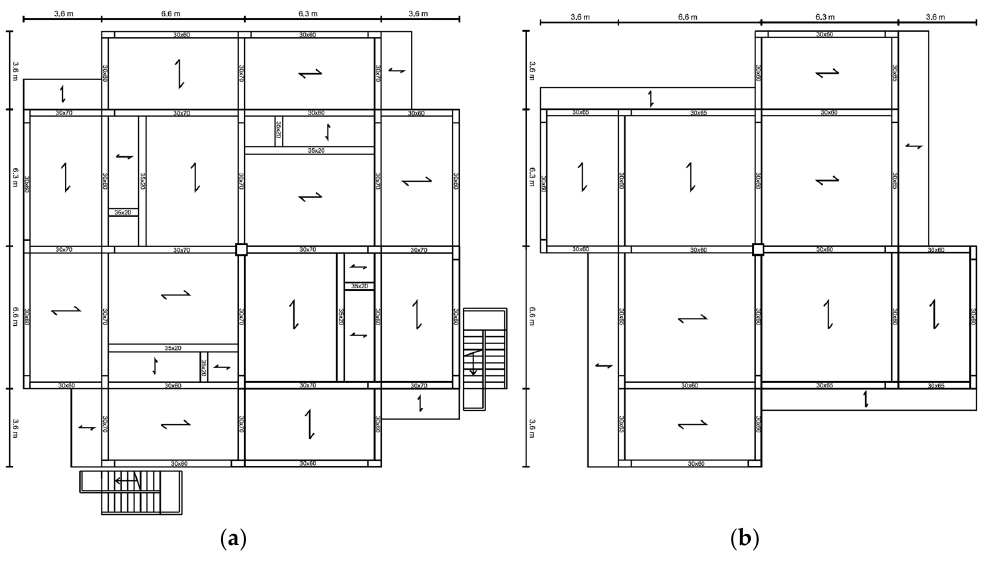
Figure 3. First floor ( a ) and roof ( b ) plans.